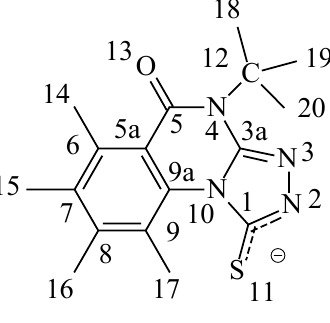
Figure 1a. Numbering of the model compound 3 -